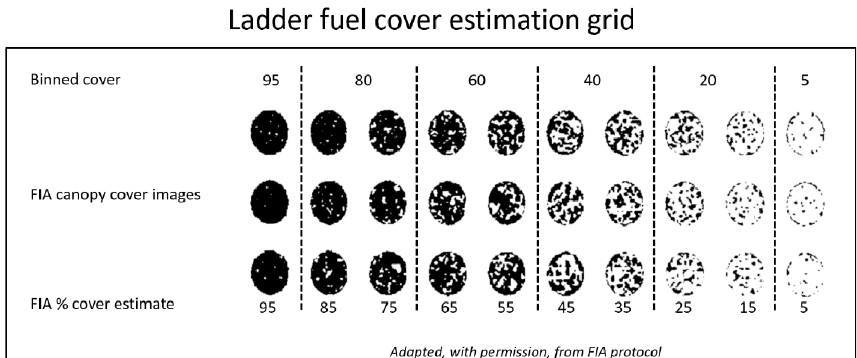
Figure 5. Binned cover estimates, used to approximate ladder fuel cover. A canopy cover image series was adapted from Forest Inventory and Analysis (FIA) protocol [70], and binned into six cover classes. The cover estimates for each image set is shown at the bottom, and the average cover in each bin is shown at the top of each class. This was also the diagram used to assist technicians in assigning cover estimates.